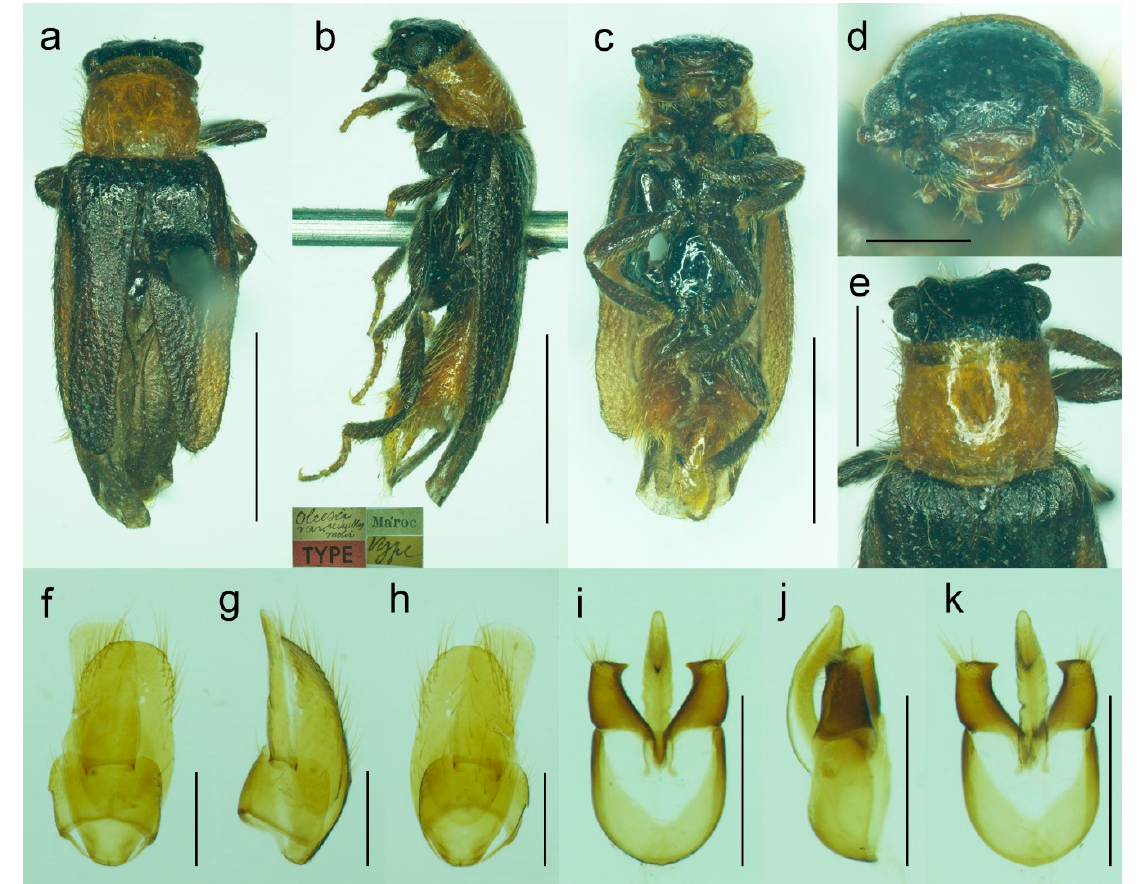
Figure 9. Malacogaster maculiventris Reitter, 1894, male lectotype. ( a ) Habitus, dorsal view; ( b ) habi- tus, lateral view; ( c ) habitus, ventral view; ( d ) right antenna; ( e ) head, frontal view; ( f ) pronotum, dorsal view; ( g ) genital capsule formed by tergites IX and X, and sternite IX, dorsal view; ( h ) genital capsule formed by tergites IX and X, and sternite IX, lateral view; ( i ) genital capsule formed by tergites IX and X, and sternite IX, ventral view; ( j ) aedeagus, dorsal view; ( k ) aedeagus, lateral view;